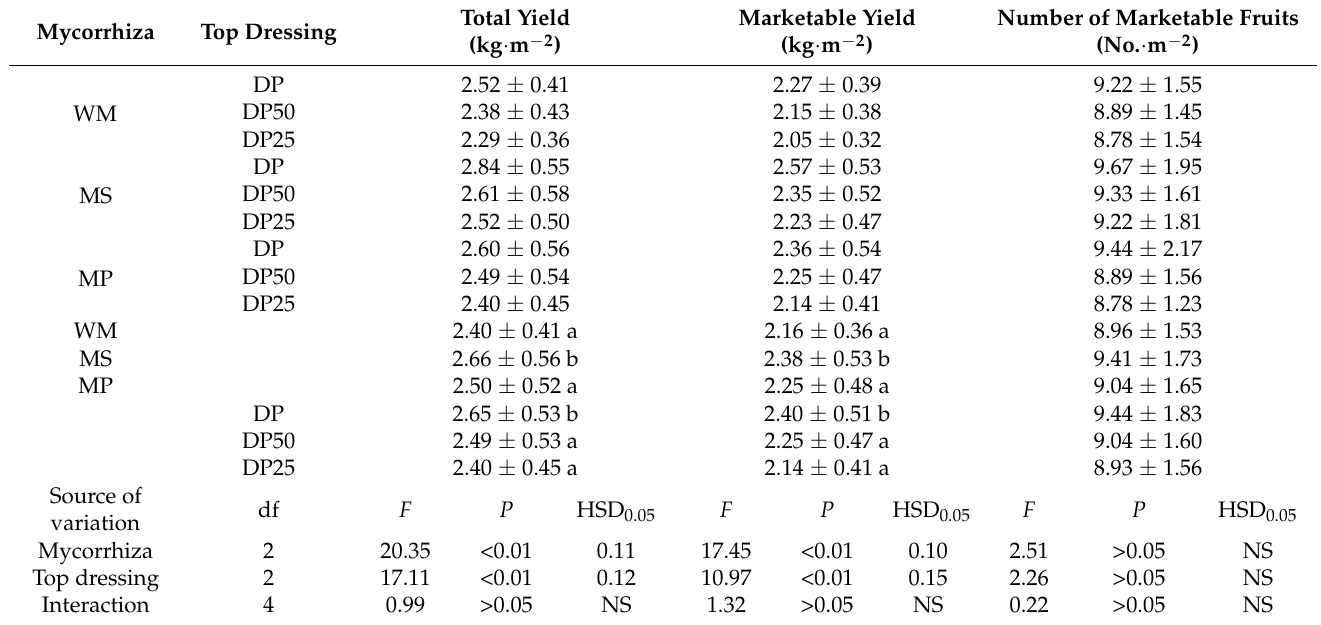
Table 1. Effect of AMF inoculation and top dressing doses on sweet pepper fruit yield and number of marketable fruits per m 2 ; on average across three years